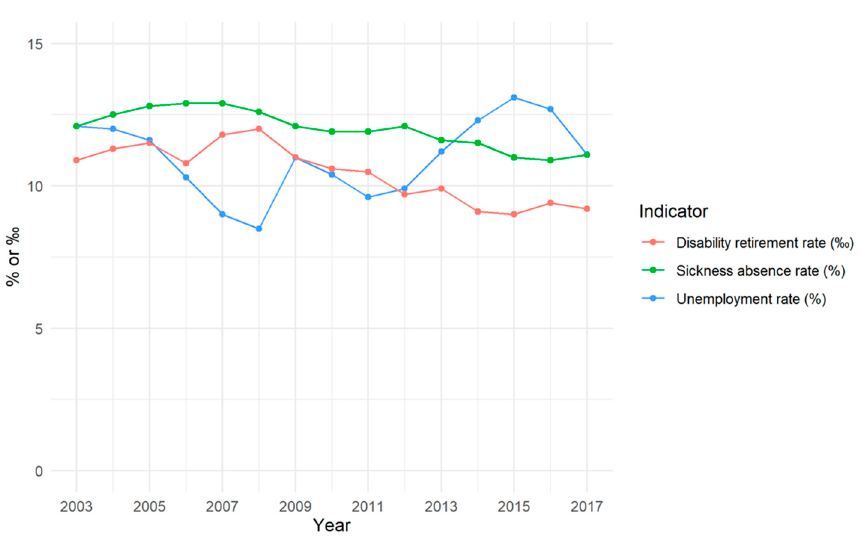
Figure A1. Average unemployment rate (%), sickness absence rate (%) and disability retirement rate (‰) in 2003–2017 calculated from unweighted municipality-level yearly observations.